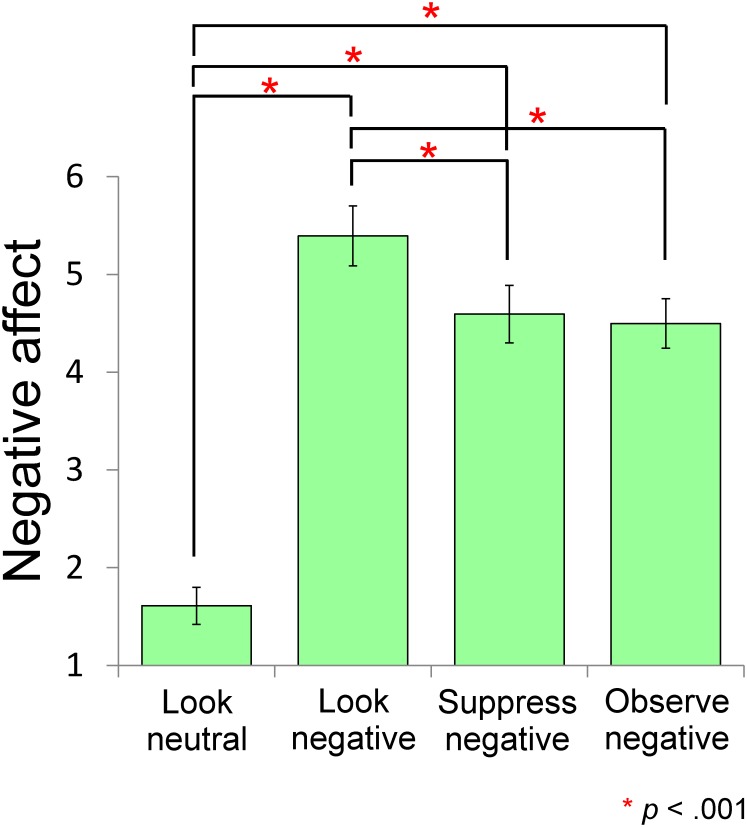
VAS scores for negative affect after each coping strategy (bars represent standard errors).Significant differences were found for the comparisons of Look-neutral vs. other conditions and Look-negative vs. Suppress-negative, and Observe-negative. The two types of emotion regulation strategies were effective for regulation of subjective emotion.